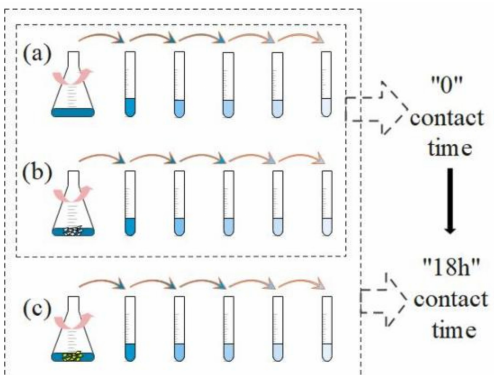
Figure 2. Steps of oscillation and dilution during the quantitative experiments. (( a ) blank group, ( b ) control group and ( c ) experimental group; each group consisted of three identical flasks, and the operation procedure was exactly the same). ”0” contact time: oscillated ( a , b ) for 1 min at 24 ◦ C, 250 r/min; “18 h” contact time: oscillated ( a – c ) for 18 h at 24 ◦ C, 150 r/min; the bacterial suspensions taken from each flask were successively diluted to five gradients (10 1 , 10 2 , 10 3 , 10 4 , 10 5